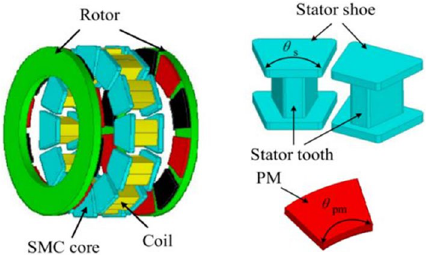
Figure 14 Structure of a YASA with an SMC